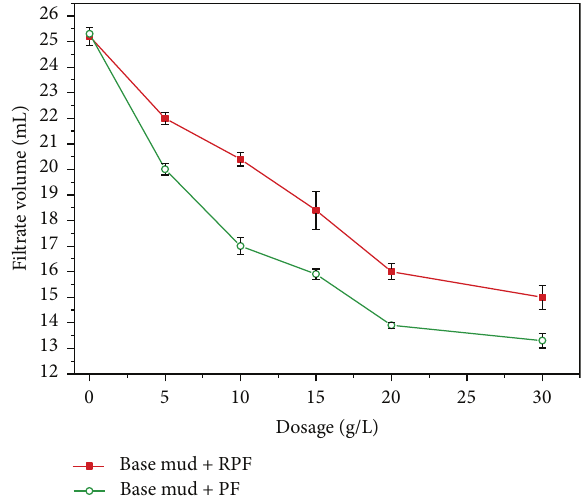
Figure 8: The effect of RPF and PF concentration on the API filtration loss of fresh water mud.